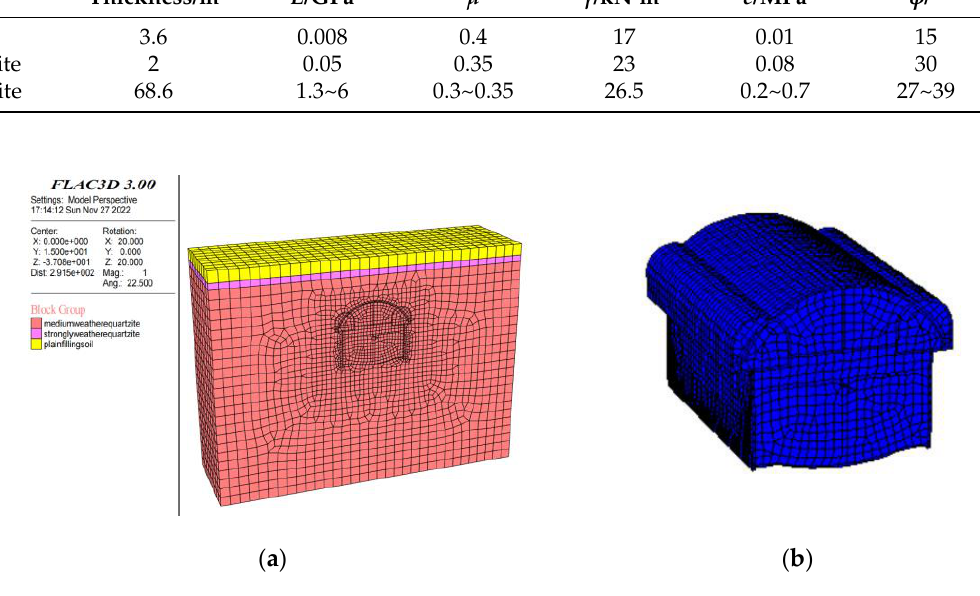
Figure 5. Numerical calculation model: ( a ) overall model; ( b ) model of the station. Table 3. Basic mechanical parameters of surrounding rock